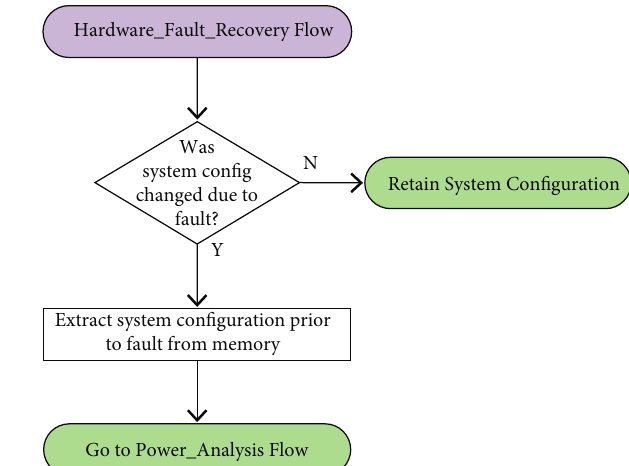
Figure 12: Hardware_Fault_Recovery flow of